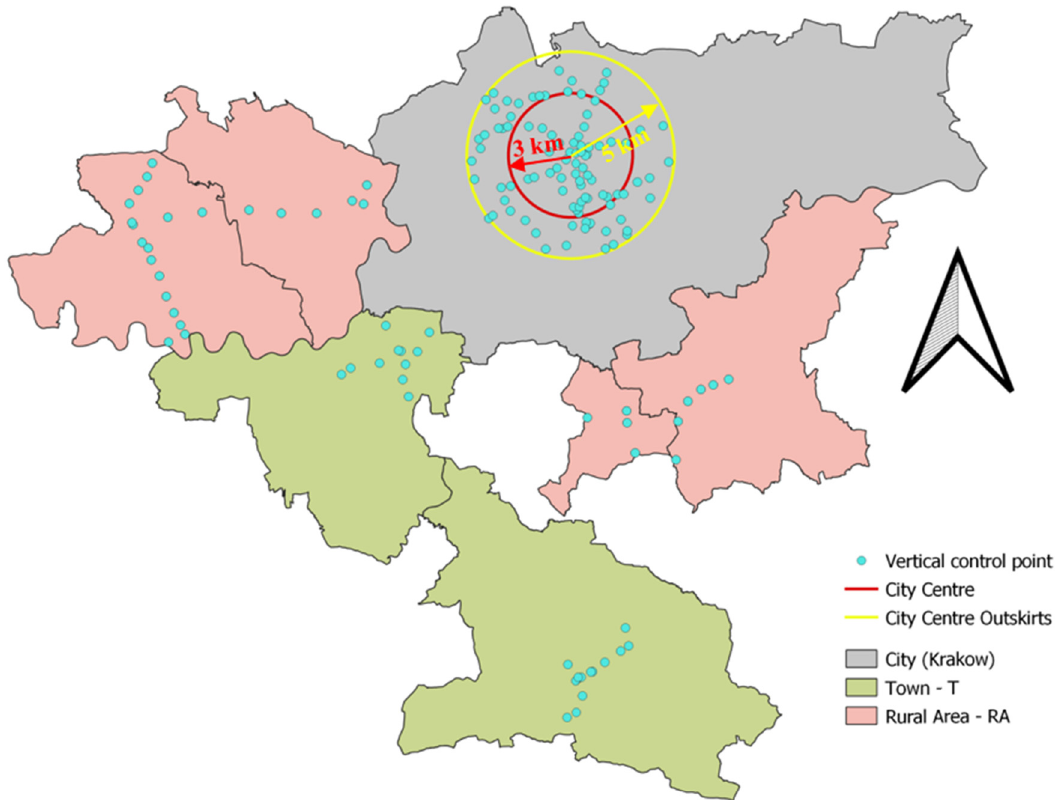
Figure 7: Presentation of selected control points in selected types of